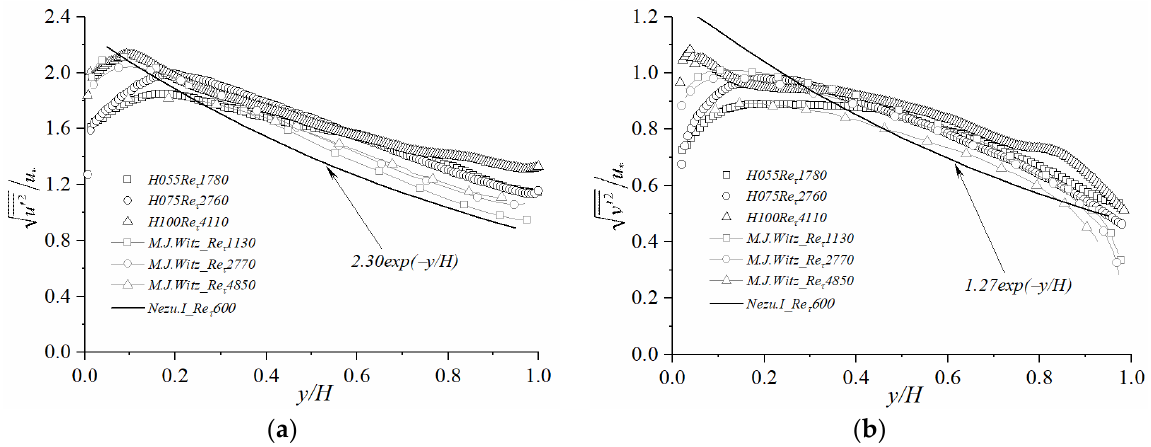
Figure 5. Profiles of ( a ) streamwise and ( b ) wall-normal turbulence intensities.